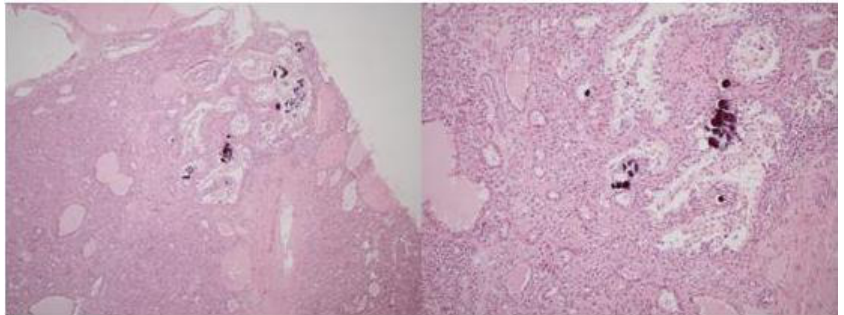
FIGURE 1 . Haematoxylin & eosin staining showing a well-demarcated papillary renal cell carcinoma containing psammoma bodies within an